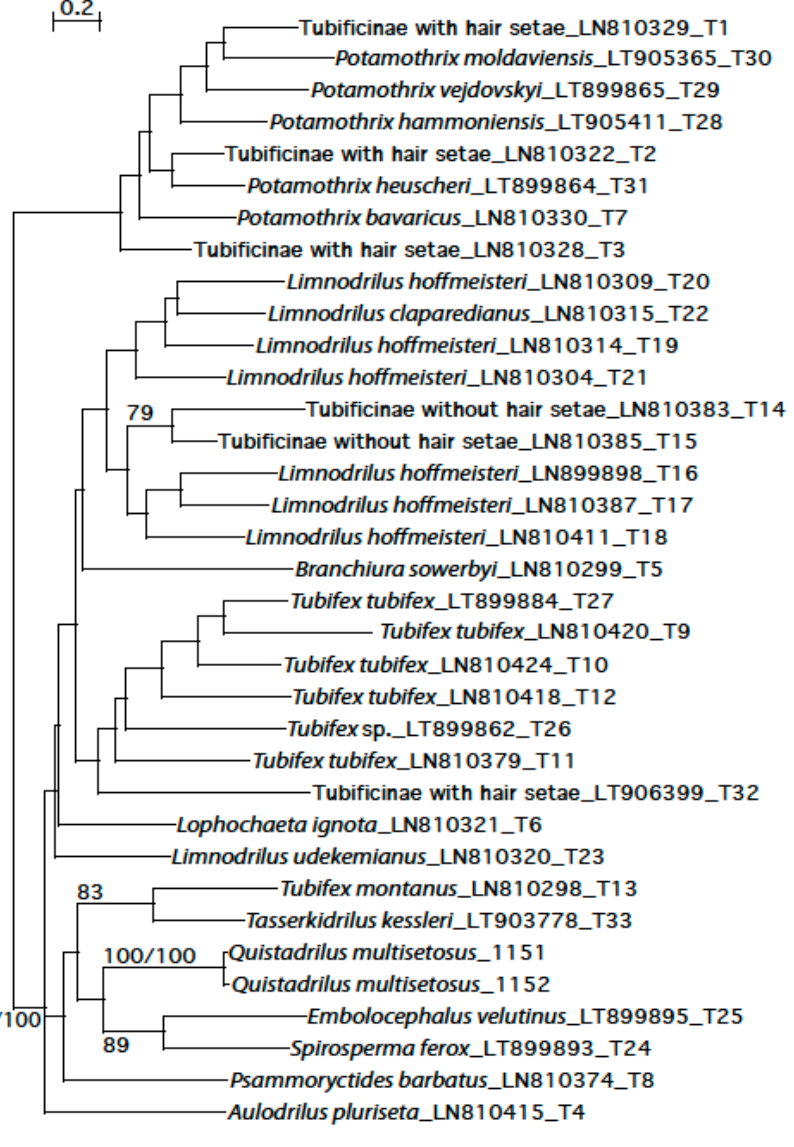
Figure 10. PhyML tree based on COI barcoding fragment of 35 sequences showing the position of Quistadrilus multisetosus within the Tubificinae. All lineages are separated by ≥ 10% of genetic divergence. The numbers placed at the internal nodes correspond to bootstrap values of ML and FastMe distance analyses; only those higher than 70% are indicated. For each lineage, the name of the taxon is indicated, followed by GenBank accession number and lineage name (of our Swiss database) or by the respective isolate numbers (for Q. multisetosus ).